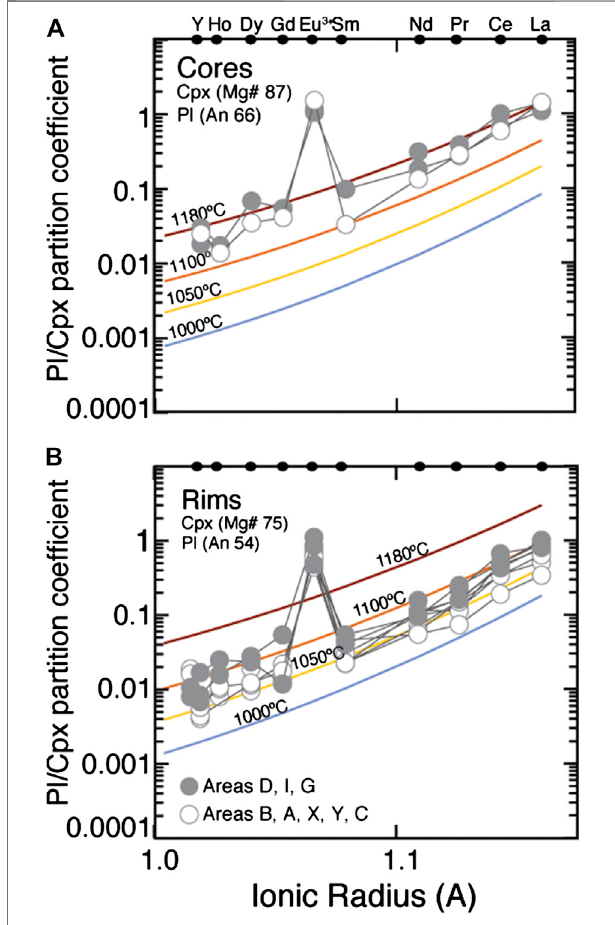
FIGURE 8 | Relationships between the Pl/Cpx trace element (Y and REE) ratios in the different areas of the studied rock and ionic radius. Equilibration temperature contour lines are calculated on the basis of the mineral major element compositions for core (A) and rim (B) compositions using the Pl/Cpx partitioning model developed by Sun and Liang (2012) and Sun et al.